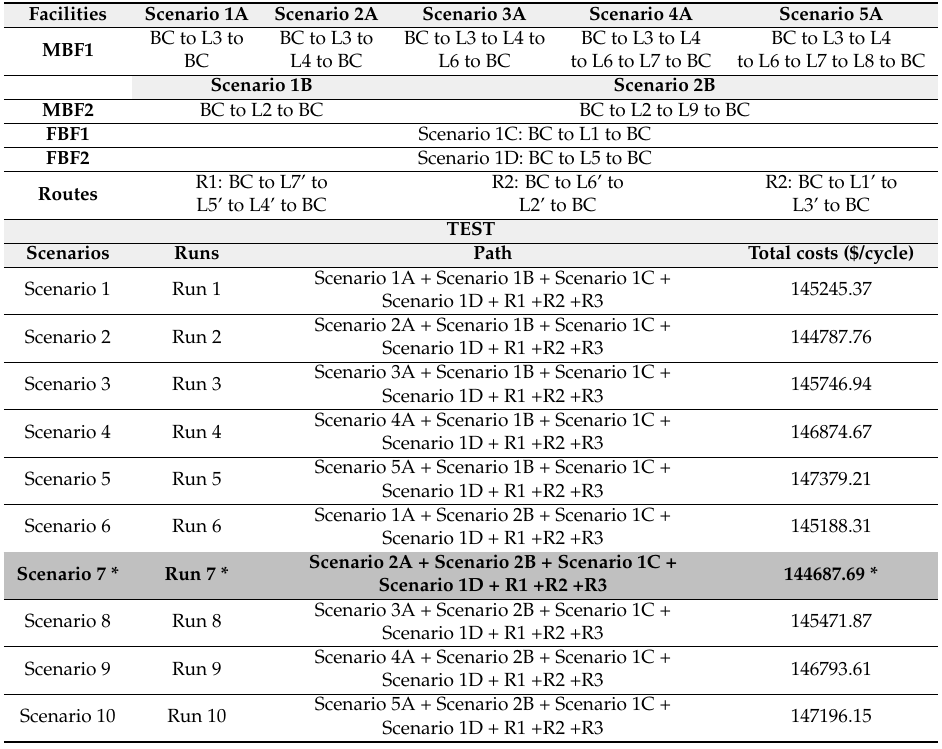
Table 9. Results of different delivery